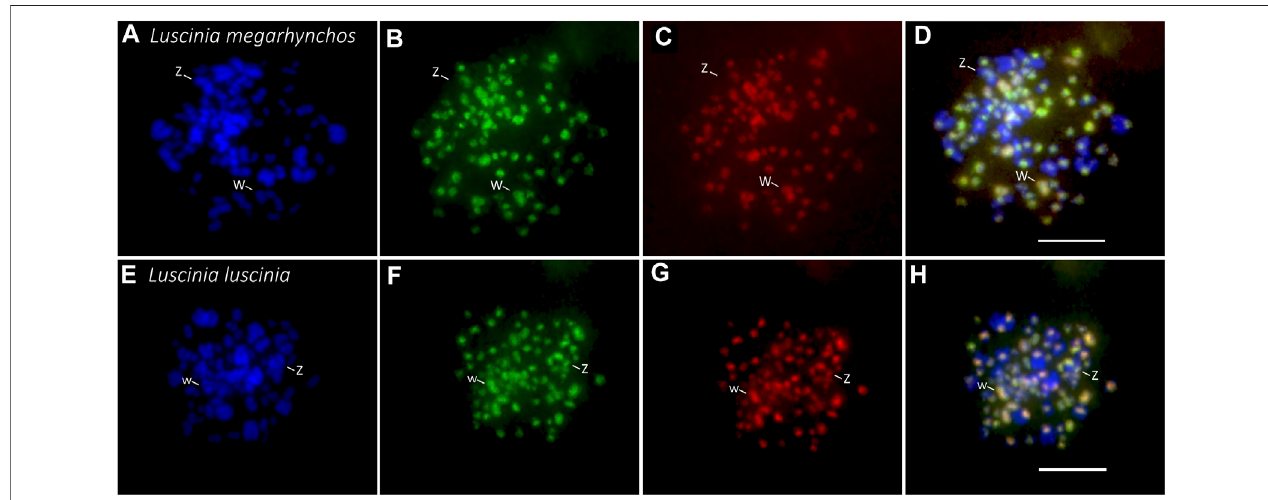
FIGURE 5 | Interspeci fi c comparative genomic hybridization (CGH) in two nightingale species. Female probes of the common nightingale ( L. megarhynchos ) and the thrush nightingale ( L. luscinia ) were labelled by streptavidin-FITC (green) and anti-digoxigenin-rhodamine (red), respectively, and hybridized on common nightingale ( A – D ), and thrush nightingale ( E – H ) metaphase spreads. The fi rst column displaysDAPI images (blue) ( A,E ); the second column displays metaphases with the common nightingale DNA probe signal (green) ( B,F ); the third column displays metaphases with the thrush nightingale DNA probe signal (red) ( C,G ); the fourth column displays the merged colors of both genomic DNA probes and DAPI staining ( D,H ). Scale bar (cid:1) 10 μ